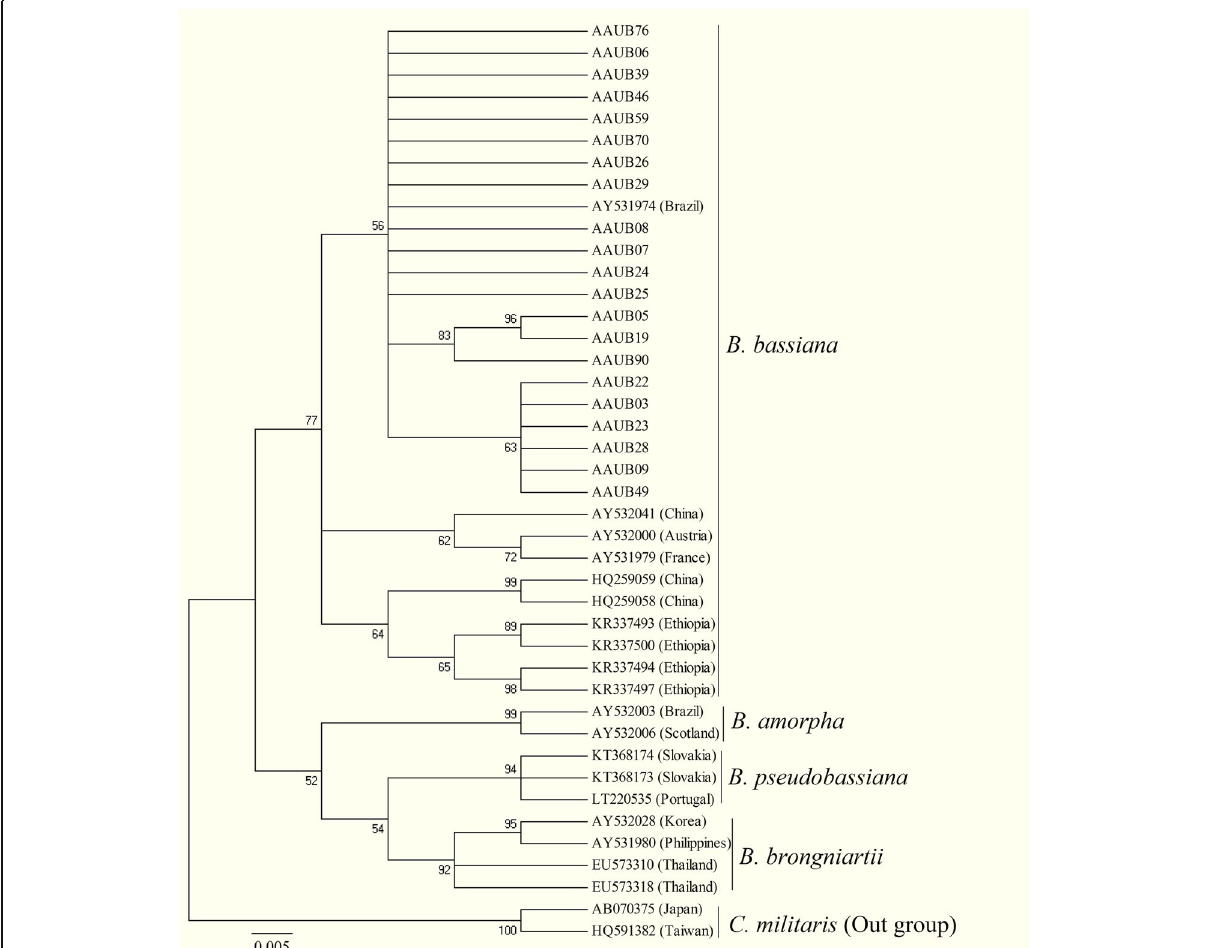
Fig. 1 Molecular phylogenic analysis of ITS region of Beauveria isolated from Ethiopian soil and other related sequences retrieved from GenBank. Maximum likelihood phylogenetic tree (MEGA4.1) based on ITS sequences from Beauveria species using the neighbor-joining model to construct the tree and the Jukes – Cantor sequence evolution algorithm, with 1000 bootstrap replications. Bootstrap values above 50% are shown. The sequences of our isolates were deposited to NCBI database with accession numbers ranging between MT588402 and MT588422,